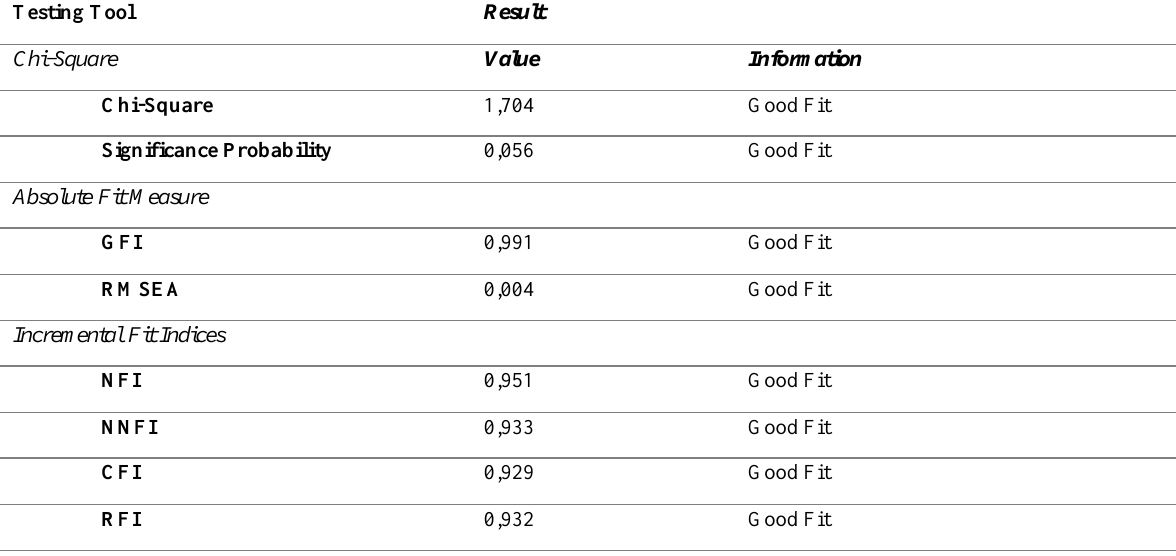
Table 4: Result of Goodness of Fit Model